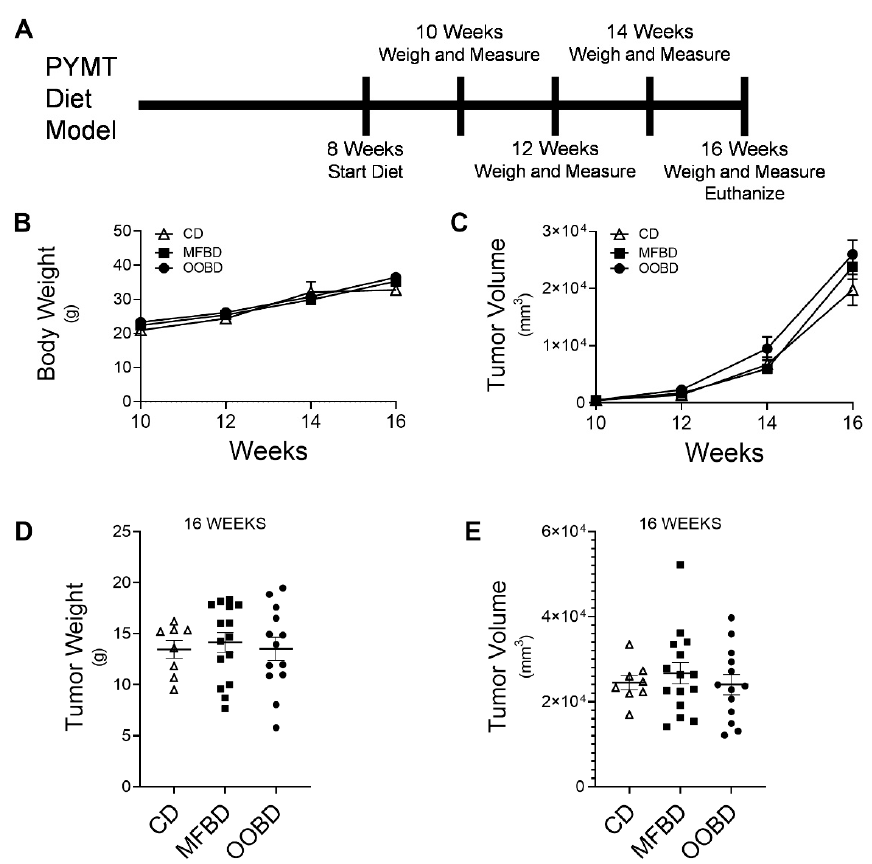
Figure 1. High fat diets (HFDs) do not alter tumor volume or weight in the mammary polyomavirus middle T antigen MMTV-PyMT breast cancer model. ( A ) Scheme for diets and MMTV-PyMT breast MMTV-PyMT breast cancer model. ( A ) Scheme for diets and MMTV-PyMT breast cancer model. Female MMTV-PyMT cancer model. Female MMTV-PyMT mice on the FVB background were fed a milk fat-based diet mice on the FVB background were fed a milk fat-based diet (MFBD), olive oil-based diet (OOBD), or an isocaloric control (MFBD), olive oil-based diet (OOBD), or an isocaloric control diet (CD) beginning at 8 weeks of age diet (CD) beginning at 8 weeks of age weeks. ( B ) Body weight was assessed every two weeks. ( C ) Tumor volume was measured at 10, 12, 14, and 16 weeks of age using calipers. ( D , E ) Tumors were excised at 16 weeks and weighed, and tumor volume was measured with calipers. Data represent mean ± standard error of the mean (SEM), n ≥ 8 for each